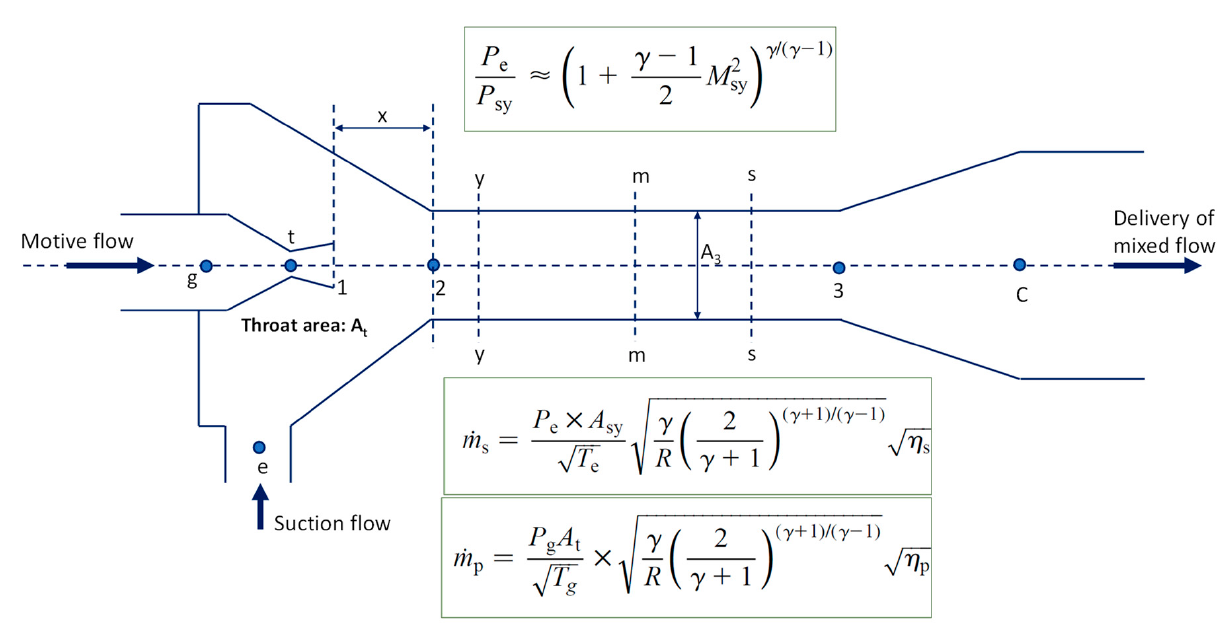
Figure A1. Notations of ejector used in the 1-D model of Huang et al. [34] .